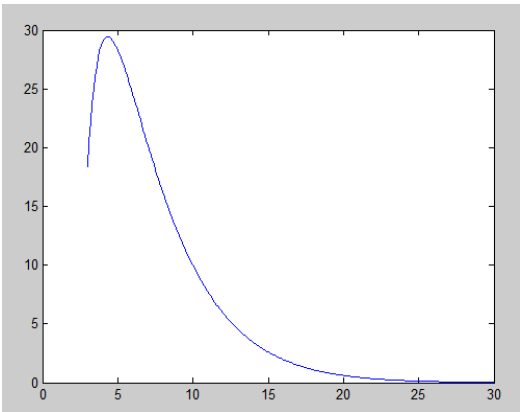
Figure 1. Partial graph of f ( e ) ( 3 30 e ).